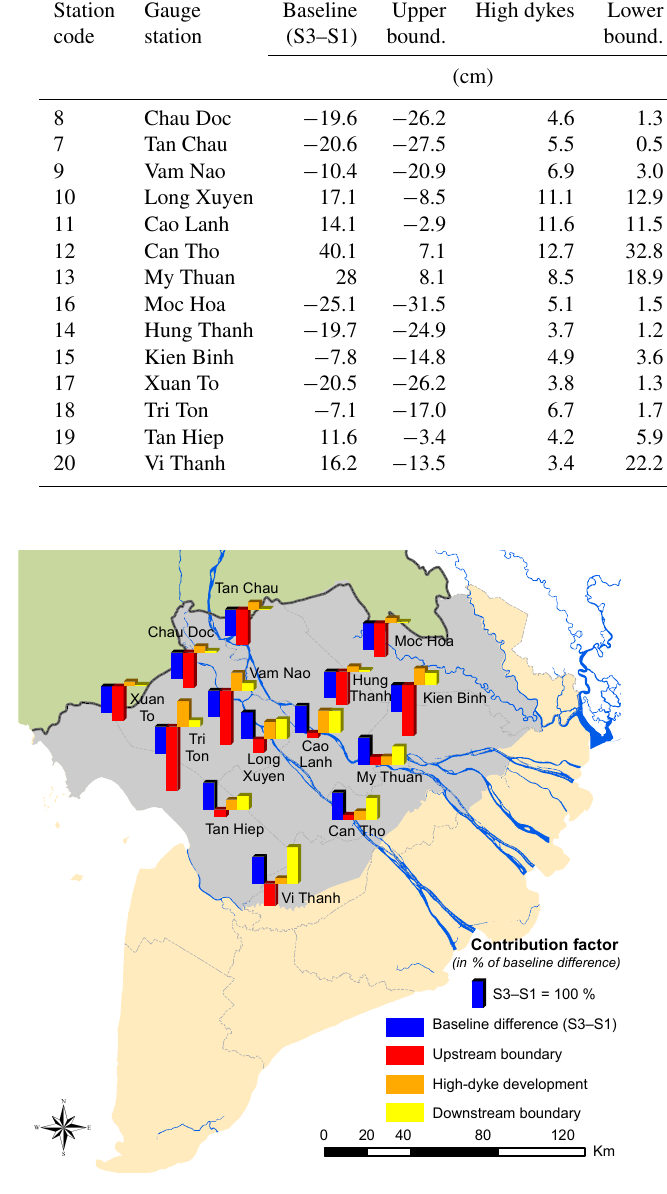
Figure 10. Contribution of each factor to the alteration of water levels between the floods 2000 and 2011 for key gauge stations in the VMD. The difference between the two scenarios S3 and S1 is considered to be